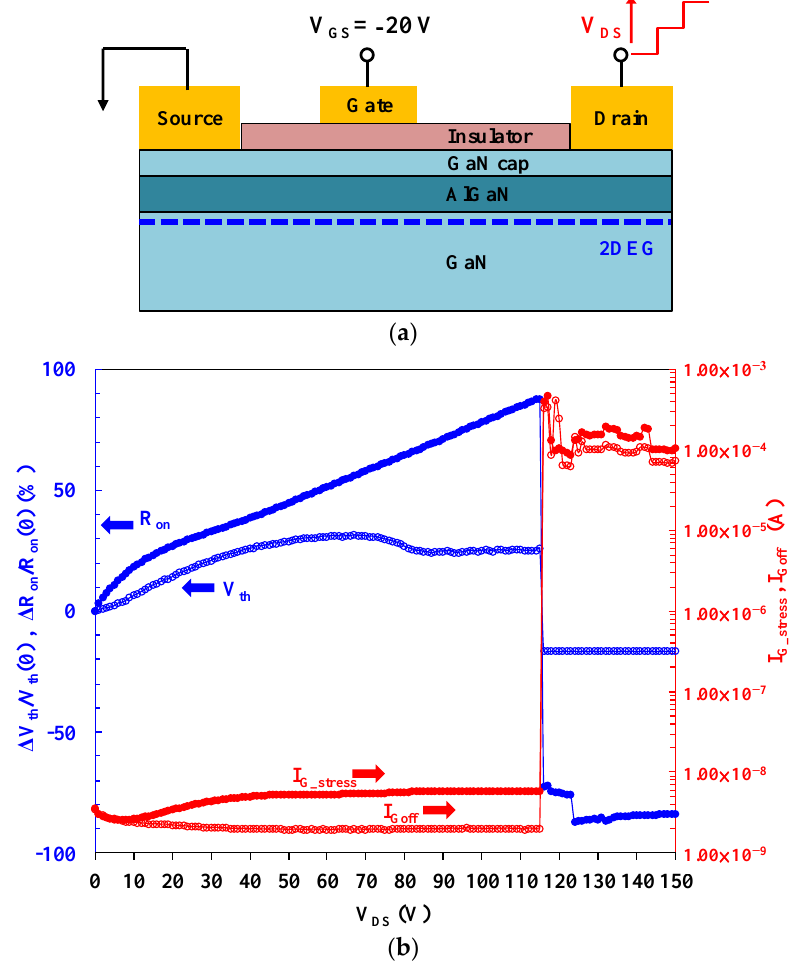
Figure 6. ( a ) Sketch of MIS-HEMT under drain voltage step-stress at off-state from V DS = 1 V to 150 V in 1 V step (3 min per step). A high-field appears at the drain-side edge of the gate electrode; ( b ) Change in normalized R on , V th , I G_stress , and I Goff as a function of stress voltage. There is a negligible degradation up to around V DS = 114 V. At this critical voltage, degradation in all figures of merit starts sharply and increases as the stress experiment proceeds.